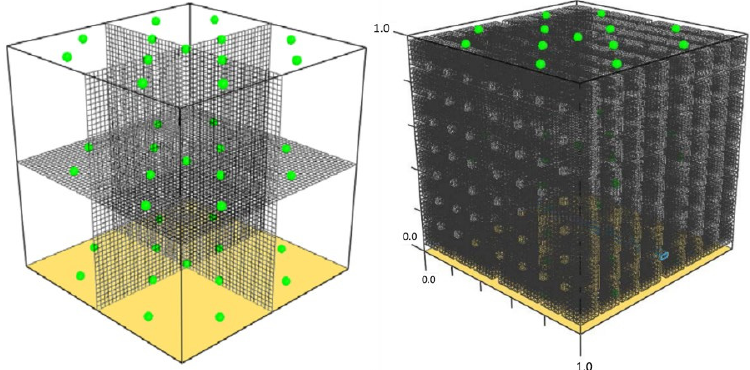
Figure 3. Mesh of the cube with the control points and the calculation subdivisions.